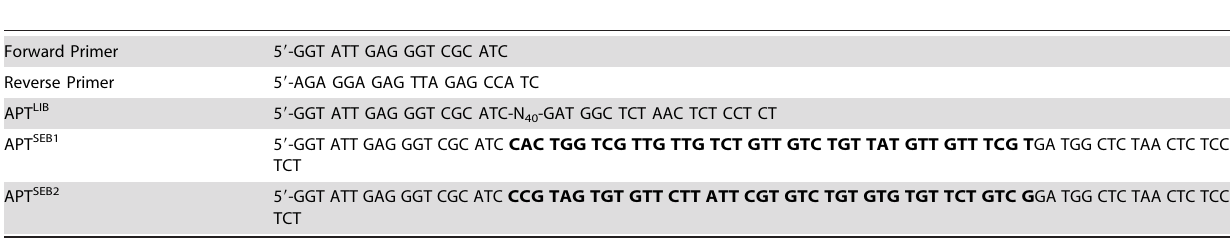
Table 1. The primer and library sequences used in this study as well as the sequences of the two aptamers discovered in this work. APT SEB1 was reported in 48 out of 49 sequences.